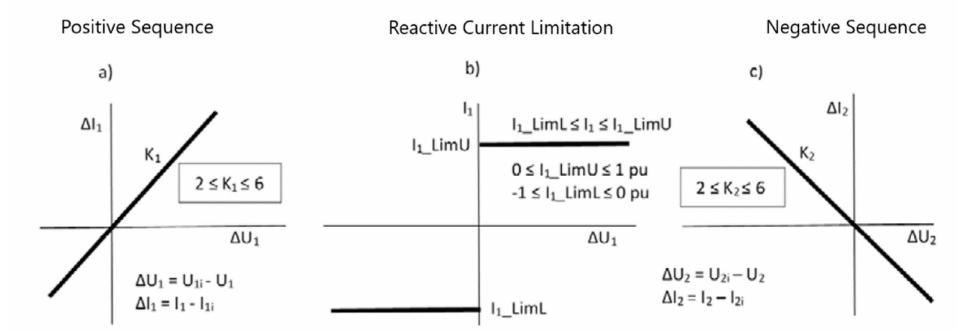
Figure 2. ( a ) Positive sequence reactive current injection/absorption additionally required pro- portional to the positive sequence voltage error; ( b ) positive sequence total reactive current injec- tion/absorption limitation; ( c ) negative sequence reactive current injection/absorption additionally required proportional to the negative sequence voltage error